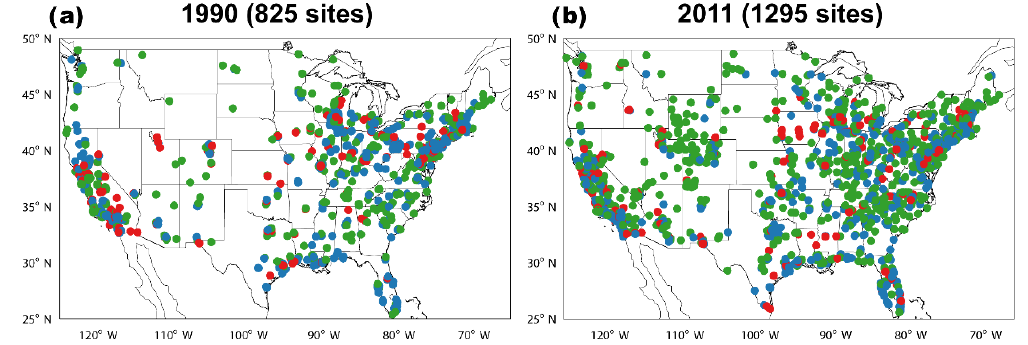
Figure 1. AQS ozone site distributions in 1990 (with the fewest sites) and 2011 (with the most sites). Rural, suburban, and urban sites are shown in green, blue, and red, respectively. Table 1. Trends and correlations in observed US average ozone during 1990–2014 calculated based on different data selection criteria. Data selection criteria Ozone trend (ppbyr − 1 ) and correlation